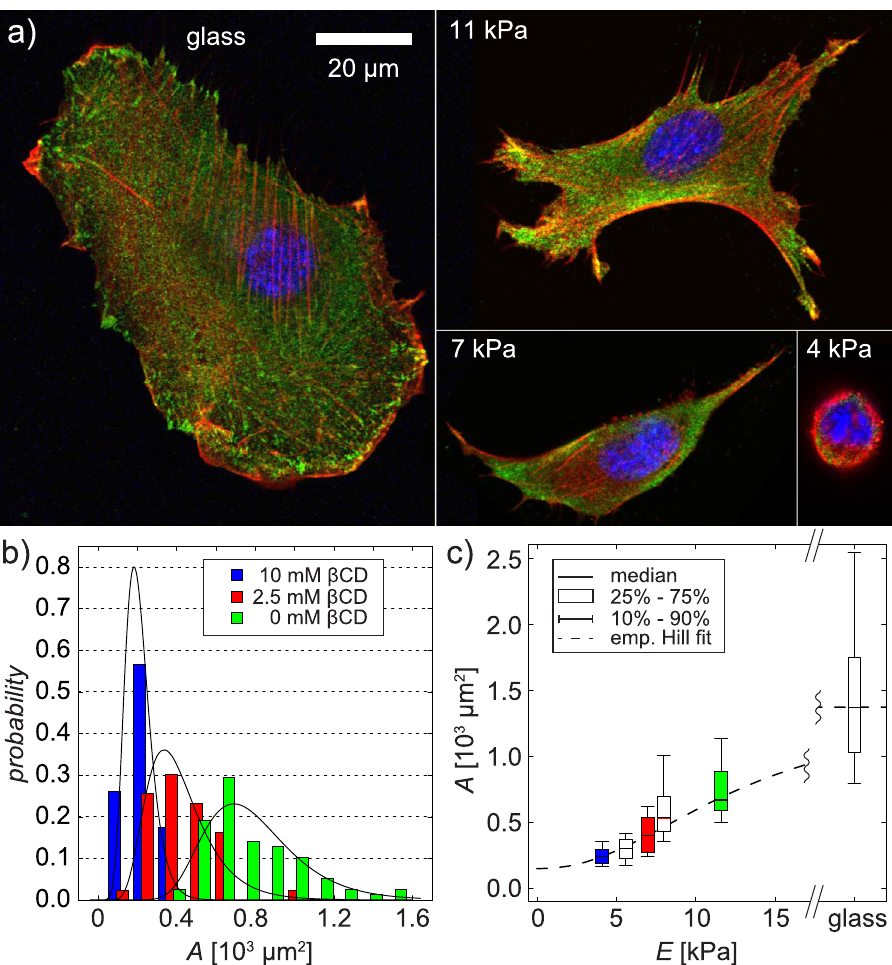
Figure 4. Ex situ mechano-sensing of C2C12. ( a ) Confocal fluorescence images of C2C12 cells on glass substrates ( E ≈ 50 GPa, control), and host-guest gel substrates with E = 11, 7, and 4 kPa. All the substrates were functionalized with fibronectin. Vinculin (green), actin (red), and nuclei (blue). ( b ) Histograms of the projected areas A of C2C12 cells at [ β CD] = 0 (green), 2.5 (red), and 10 mM (blue), taken from a total number of n > 150 cells. The distribution for each condition could be well fitted with a log-normal function. ( c ) Projected area as a function of the elastic modulus of the gel, fitted with the empirical Hill equation (broken